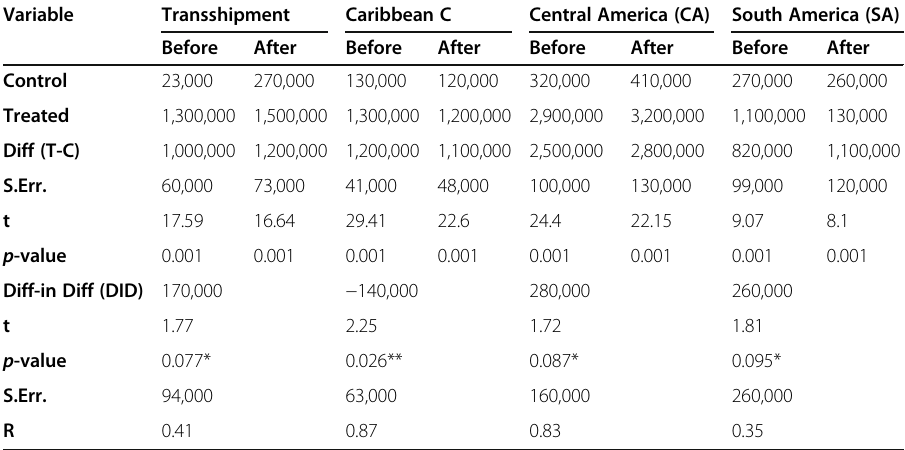
Table 7 Differences in Differences (DID) Regressions (2010 to